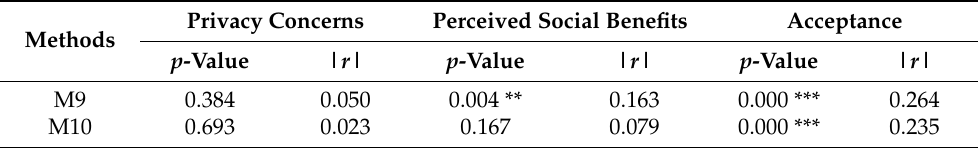
Table 10. Mann–Whitney test results for the two location disclosure methods (comparison between the U.S. and South Korea).